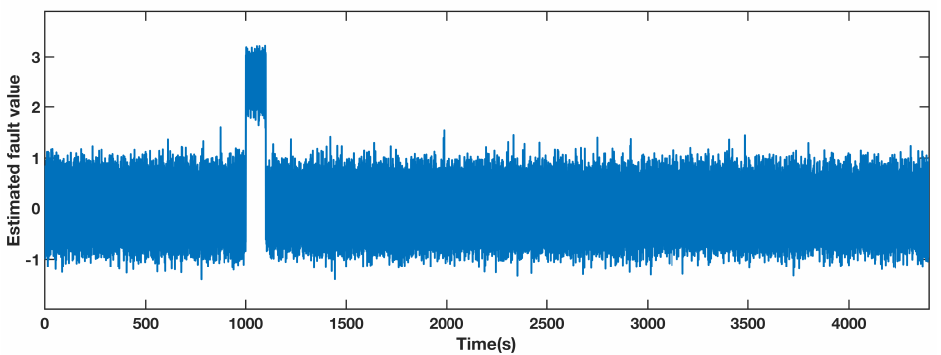
Figure 3. Estimated fault value from adaptive observer designed for the pitch angle 1.